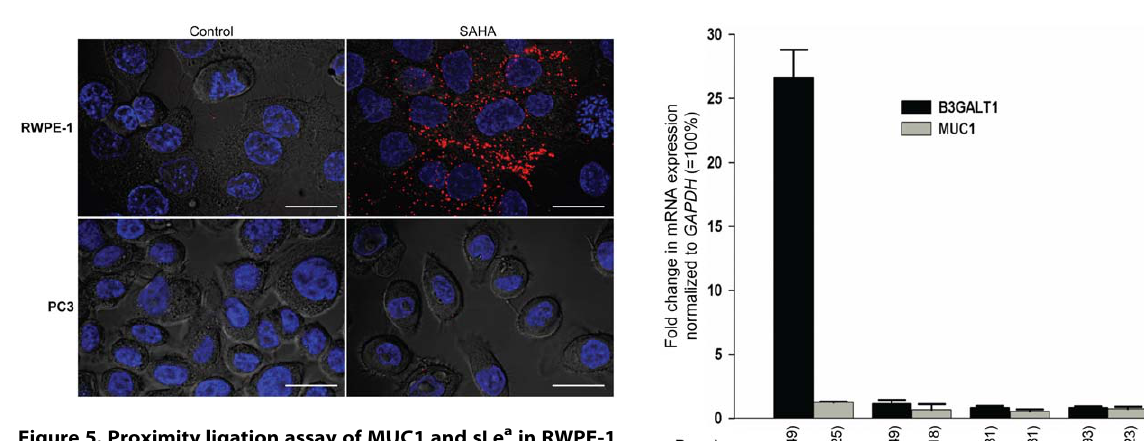
Figure 5. Proximity ligation assay of MUC1 and sLe a in RWPE-1 and PC3 cells as analyzed by confocal microscopy. RWPE-1 and PC3 cells grown on cover slips were treated with PBS or SAHA and then fixed in paraformaldehyde. These cells were processed for PLA for MUC1 and sLe a using an Olink Bioscience PLA kit. Briefly, these cells were treated with mouse anti-sLe a and rabbit anti-MUC1 antibodies, and then with oligonucleotide-conjugated anti-mouse minus and anti- rabbit plus proximity ligation assay secondary probes. The oligonucle- otides conjugated with the plus and minus antibodies were used to generate circular DNA, which was then amplified and tagged with a red fluorescence dye. Following DAPI staining of the nuclei, the cells were examined by confocal fluorescence microscopy. The expression as well as association of sLe a with MUC1, significantly increased only in SAHA treated RWPE-1 cells as indicated by red foci all over the cells. Bar = 20 m m.